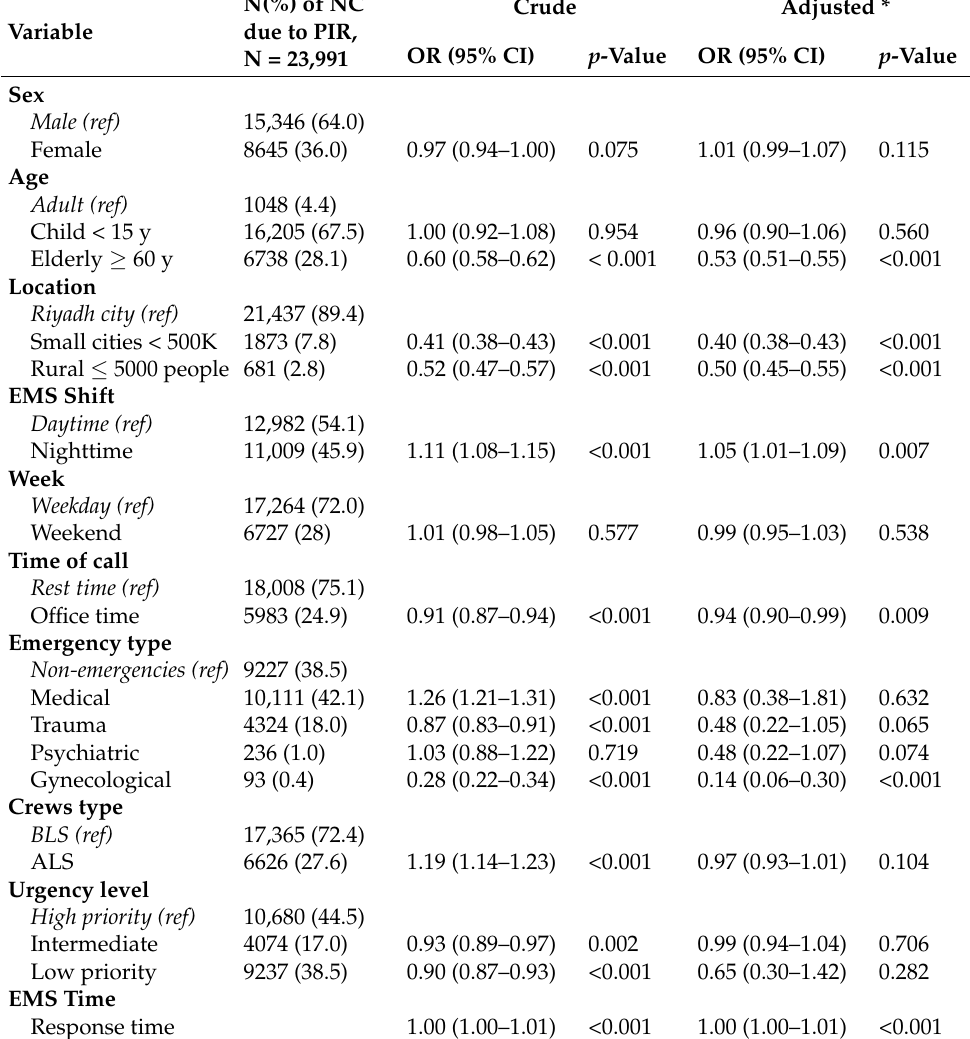
Table 3. Crude and adjusted associations between characteristics of the patient or mission, and patient-initiated refusal (n =